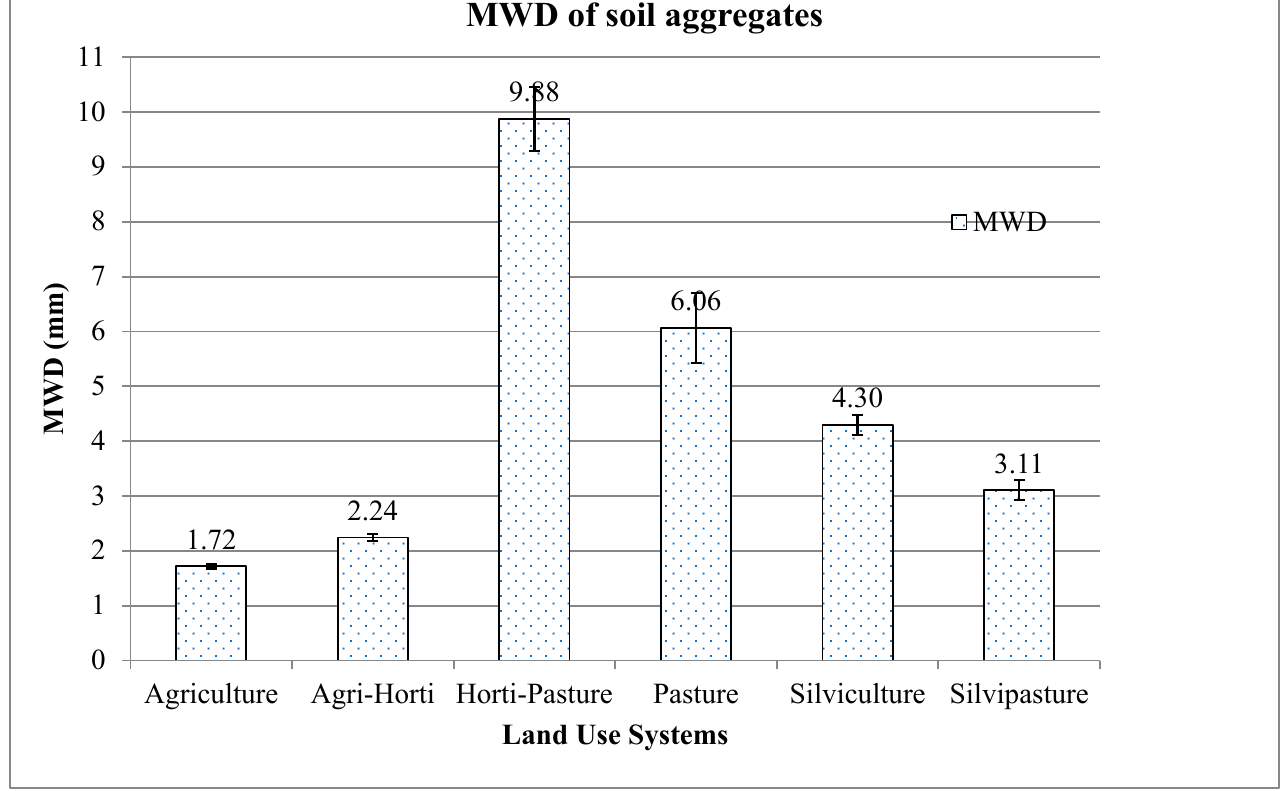
Figure 6. Mean weight diameter (MWD) of soil aggregates under different land use systems, which shows significant impact on soil aggregation at p < 0.05. T 1 —Agriculture, Glycin max .; T 2 —Agri-Horti, Manilkara achras and Glycin max ; T 3 —Horti-Pasture, Emblica officinalis and Cenchrus ciliaris ; T 4 —Pasture, Cenchrus ciliaris ; T 5 —Silviculture, Accacia nilotica ; T 6 —Silvipasture, Accacia nilotica and Cenchrus ciliaris .